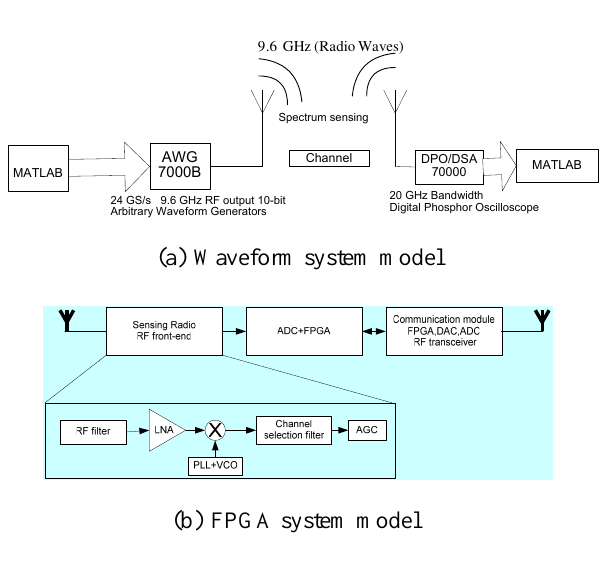
Figure 3. Experimental